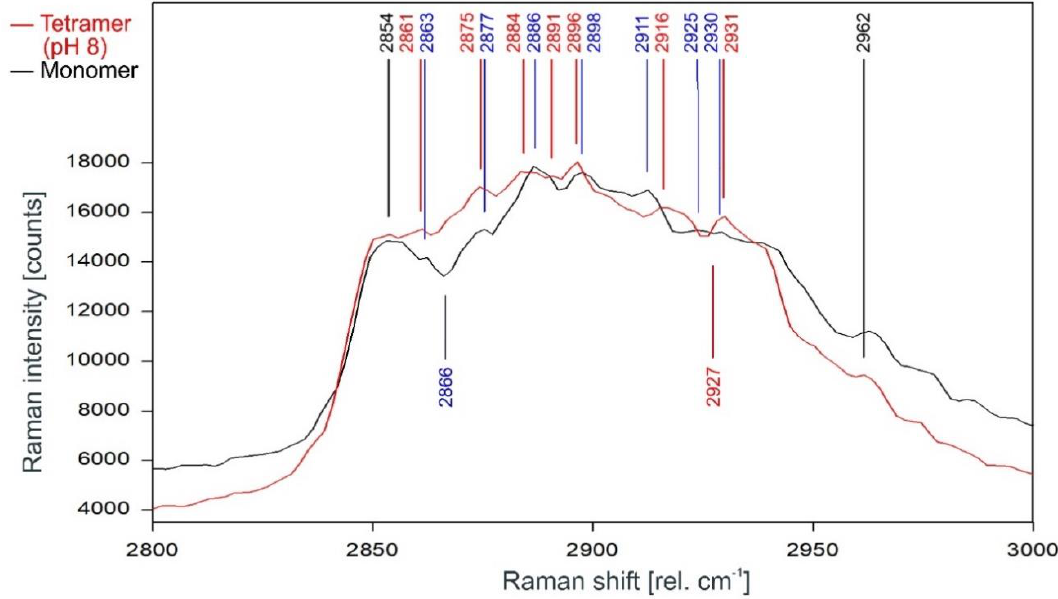
Figure 12. Comparison of the Raman spectrum of the closed KcsA channel tetramer at pH 8 (red) with the KcsA monomer (black) between 2800 and 3000 rel. cm − 1 as recorded. Raman lines shared by the spectra are marked in black, lines belonging solely to the channel protein are marked in red, exclusive monomer lines are marked in blue.